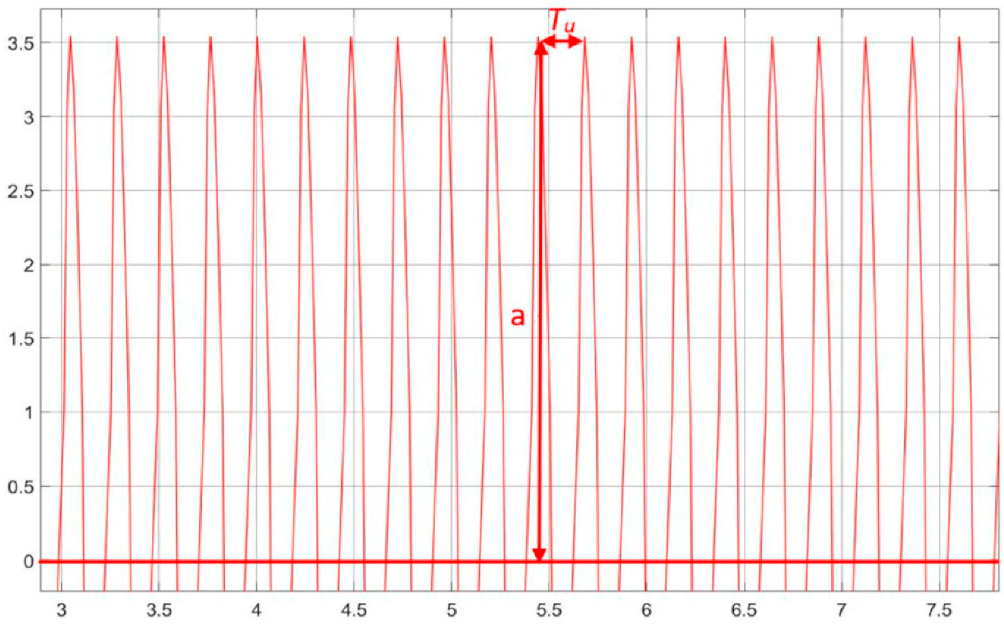
Figure 7. Step response of ECS output temperature signal with relay feedback method.